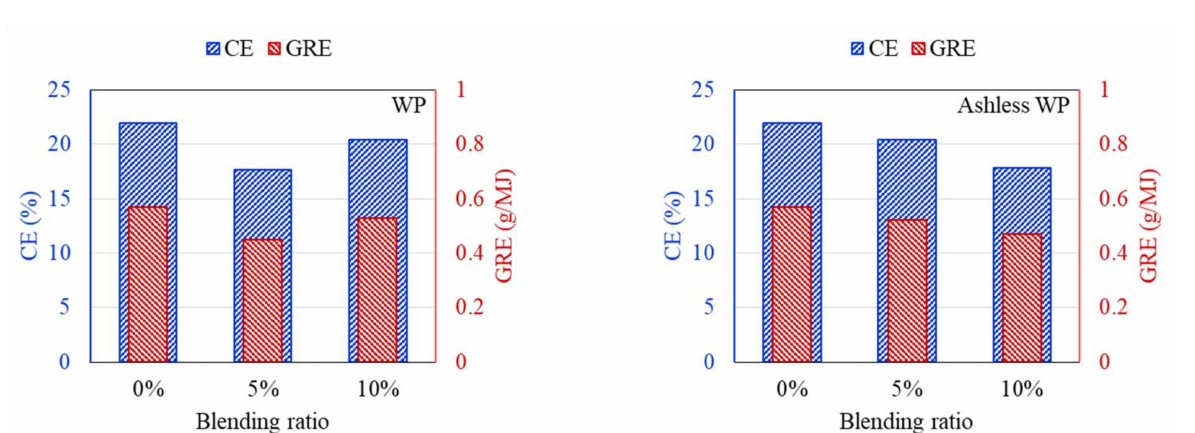
Figure 9. CE and GRE for cofiring different blends of the WP ( left ) and ashless WP ( right